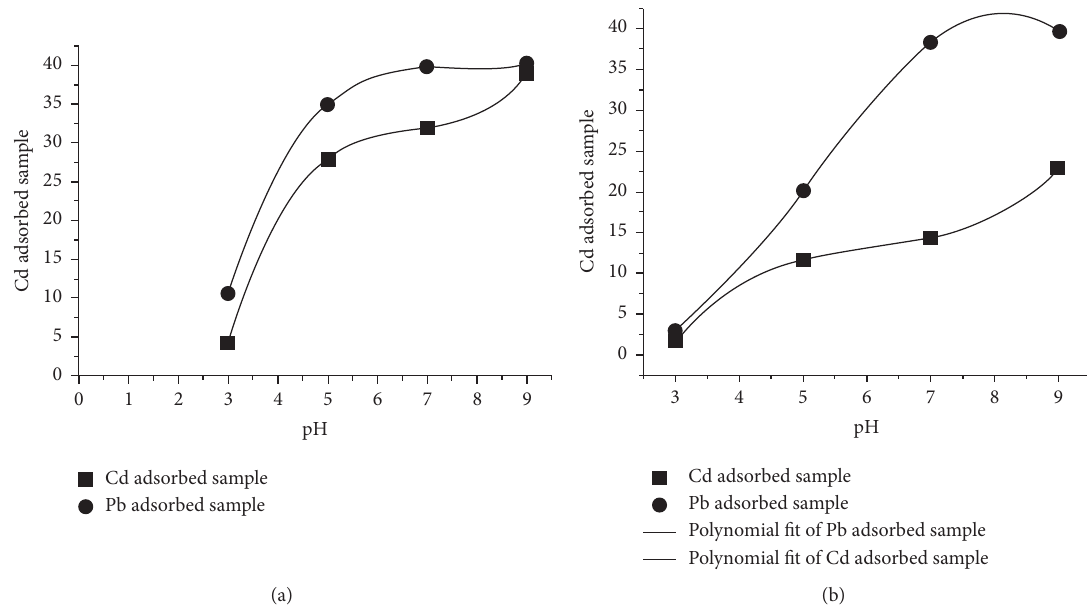
Figure 2: Graph of concentration of Cd (II) and Pb (II) adsorbed by clay-1 (a) and clay-2 (b) on y -axis against pH on x